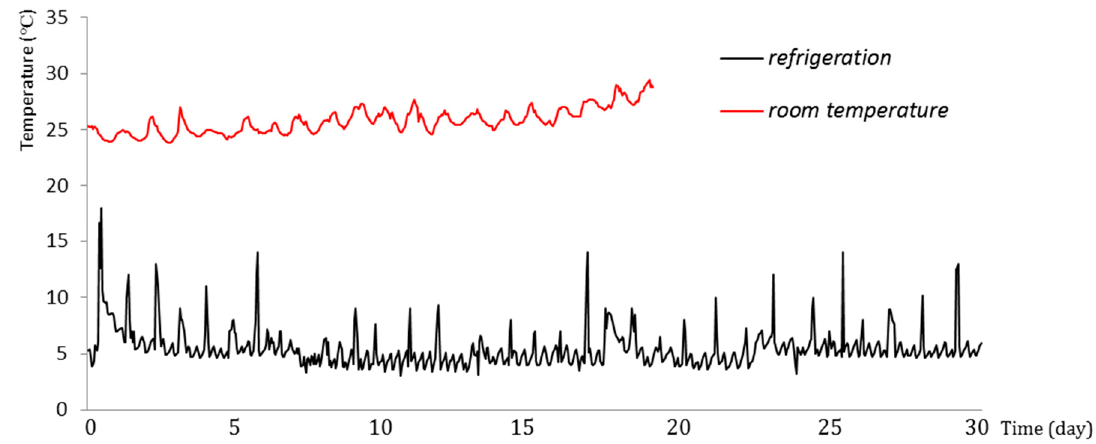
Figure 4. Time-temperature fluctuation under different storage conditions.